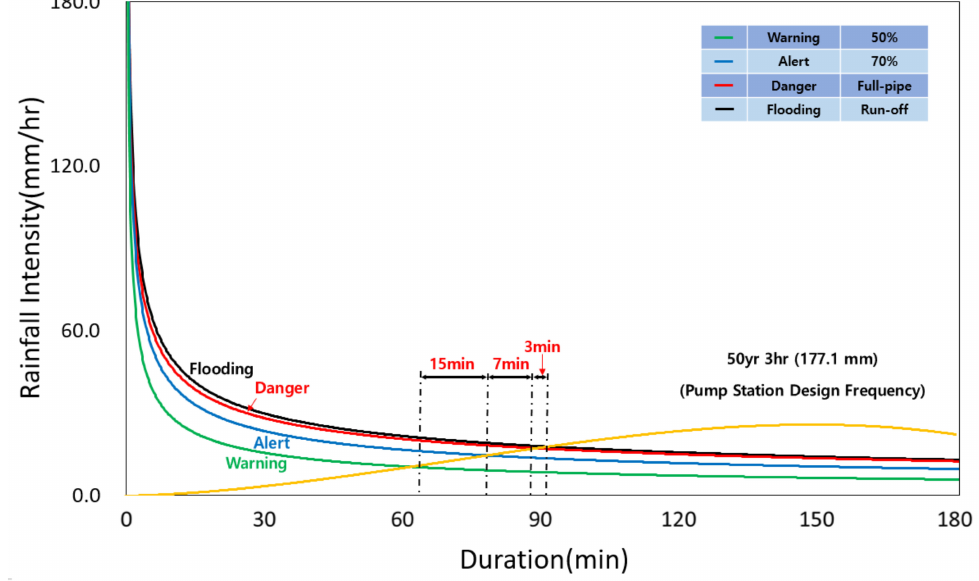
Figure 11. Flooding stages of improved flood nomograph (Shincheon